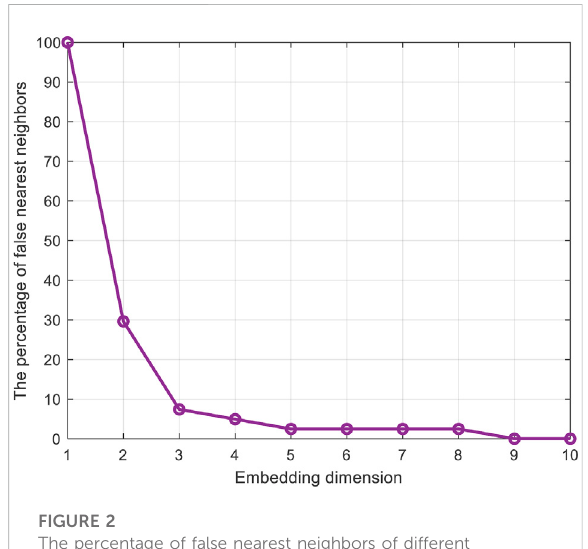
FIGURE 2 The percentage of false nearest neighbors of different embedding